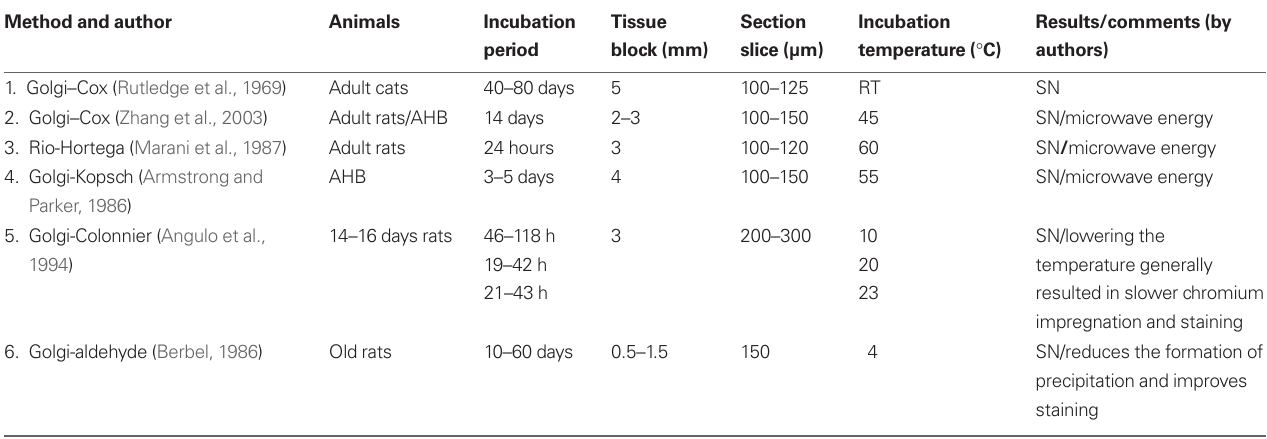
Table 3 | Comparison of impregnation of Golgi stain into the neurons under various conditions used by different authors. Method and